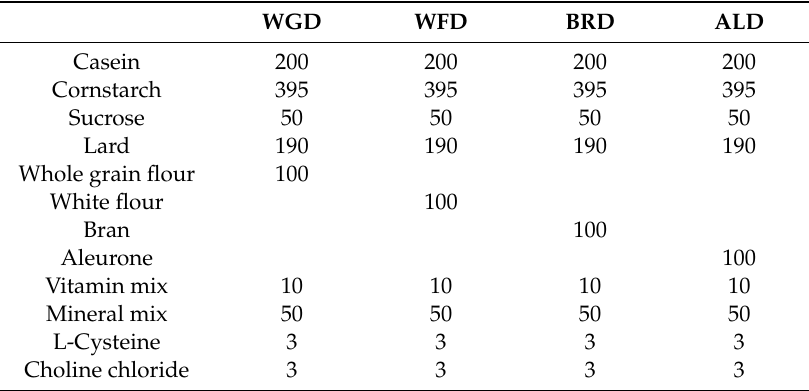
Table 1. Composition of experimental diets [g /